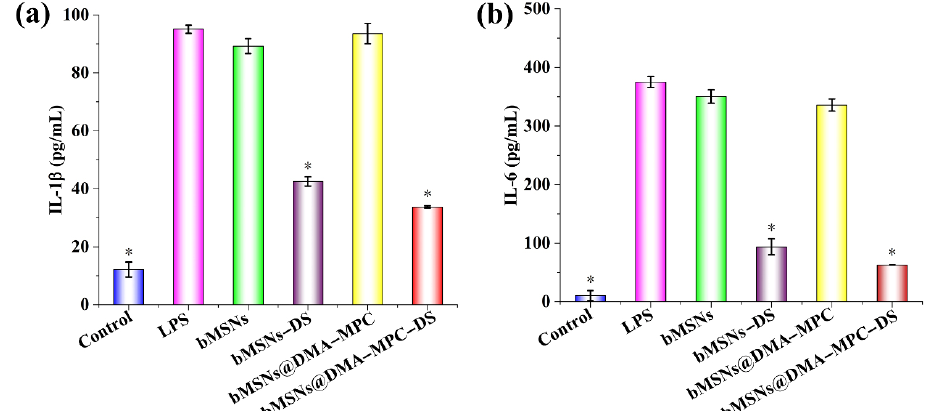
Fig. 10 Anti-inflammation properties of the drug-loaded nanoparticles characterized by incubating the activated macrophages with the same concentration of bMSNs, bMSNs–DS, bMSNs@DMA–MPC (1:4), and bMSNs@DMA–MPC (1:4)–DS for a duration of 24 h. The expression levels of inflammation factors including (a) IL-1 β and (b) IL-6 are measured using the ELISA kit. ( n = 3, * P < 0.05, for comparison with the LPS